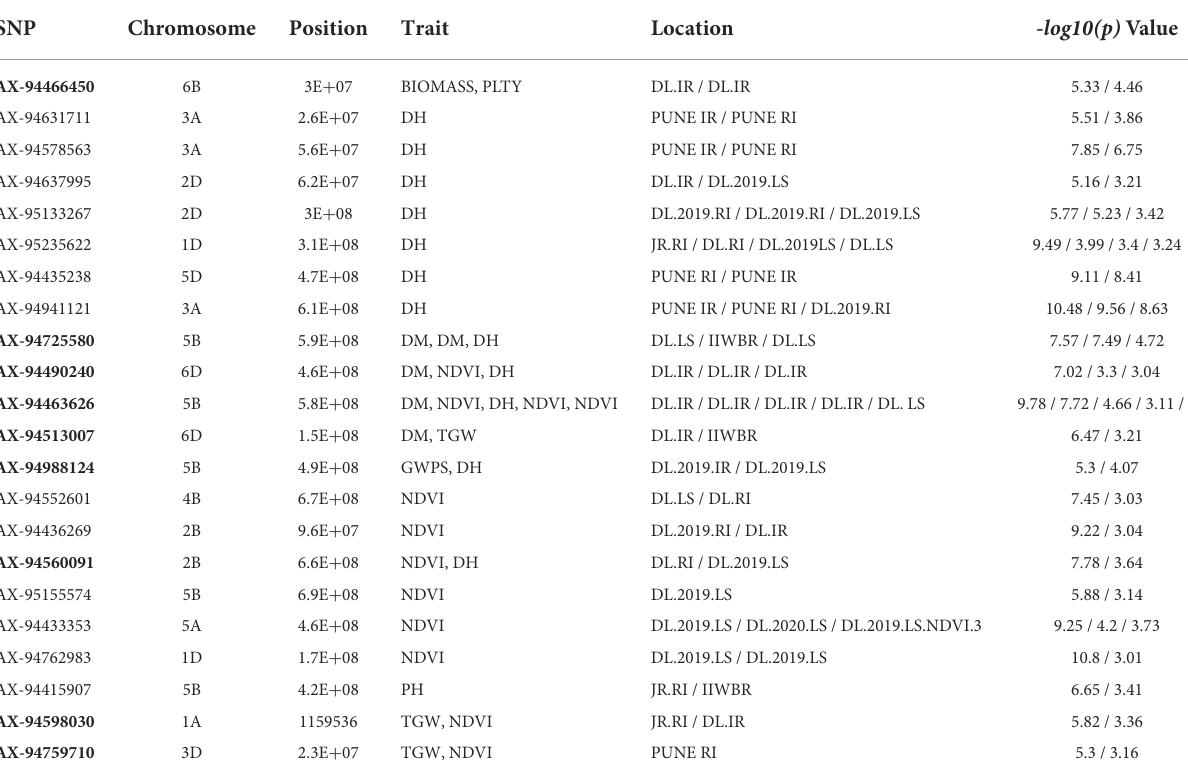
TABLE 5 List of stable SNPs expressed at more than one environment and Pleiotropic * SNPs (Bold ones) linked to more than one traits.